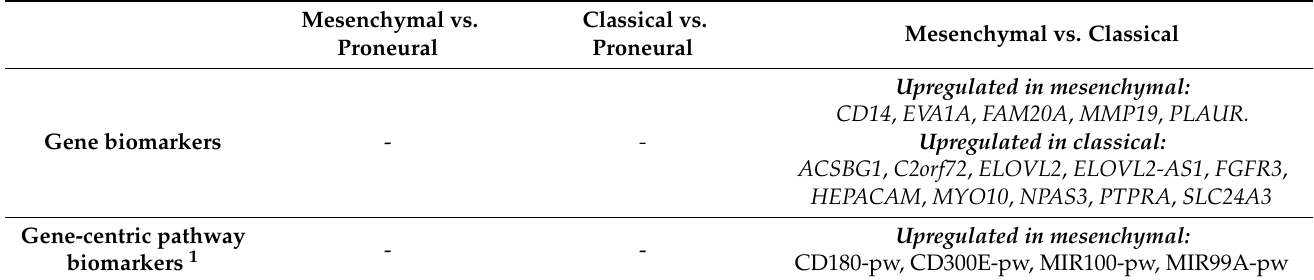
Table 2. Statistics of gene and pathway expression biomarkers distinguishing GBM molecular sub- types.